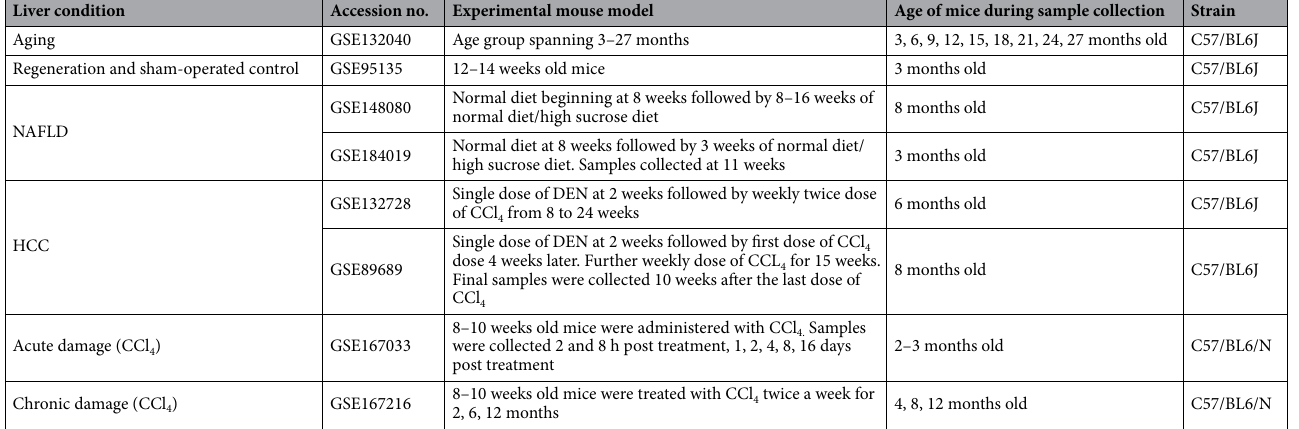
Table 1. Datasets used to define the list of candidate genes for different liver associated